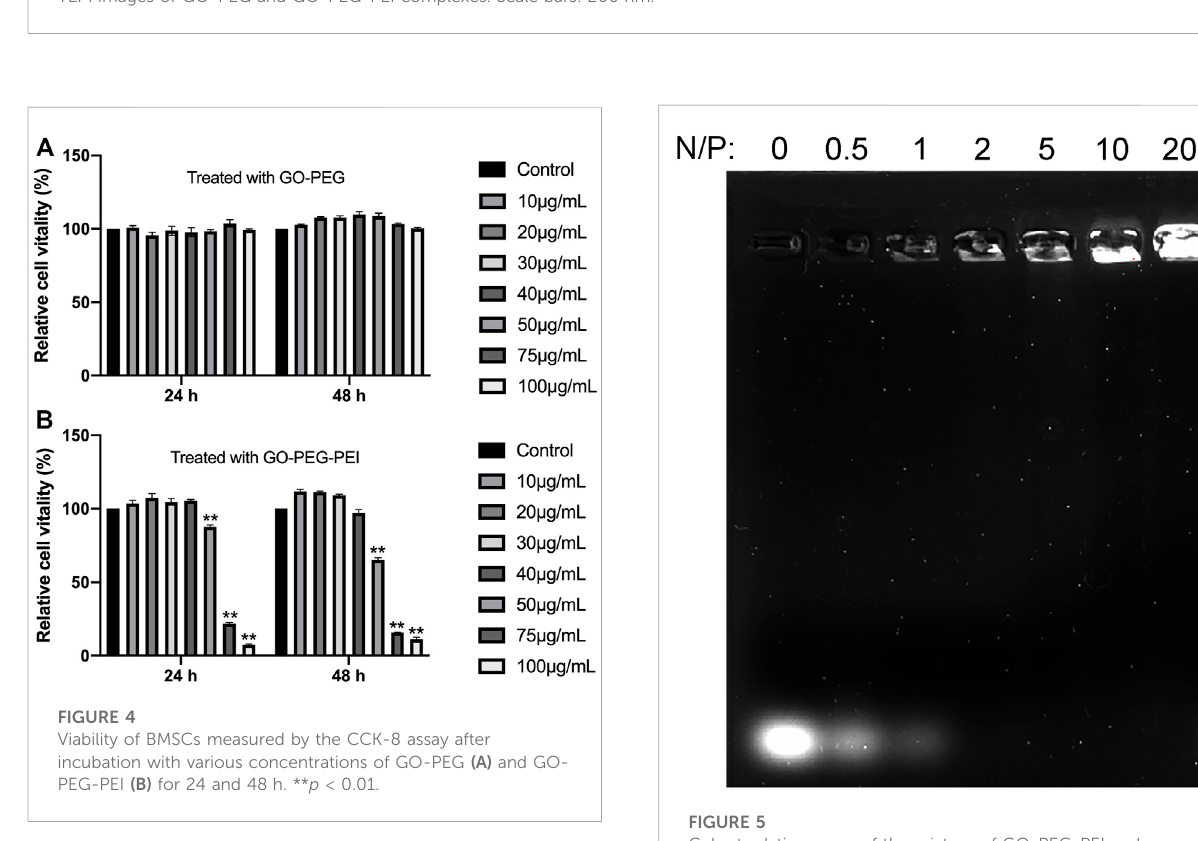
FIGURE 3 TEM images of GO-PEG and GO-PEG-PEI complexes. Scale bars: 200 nm.